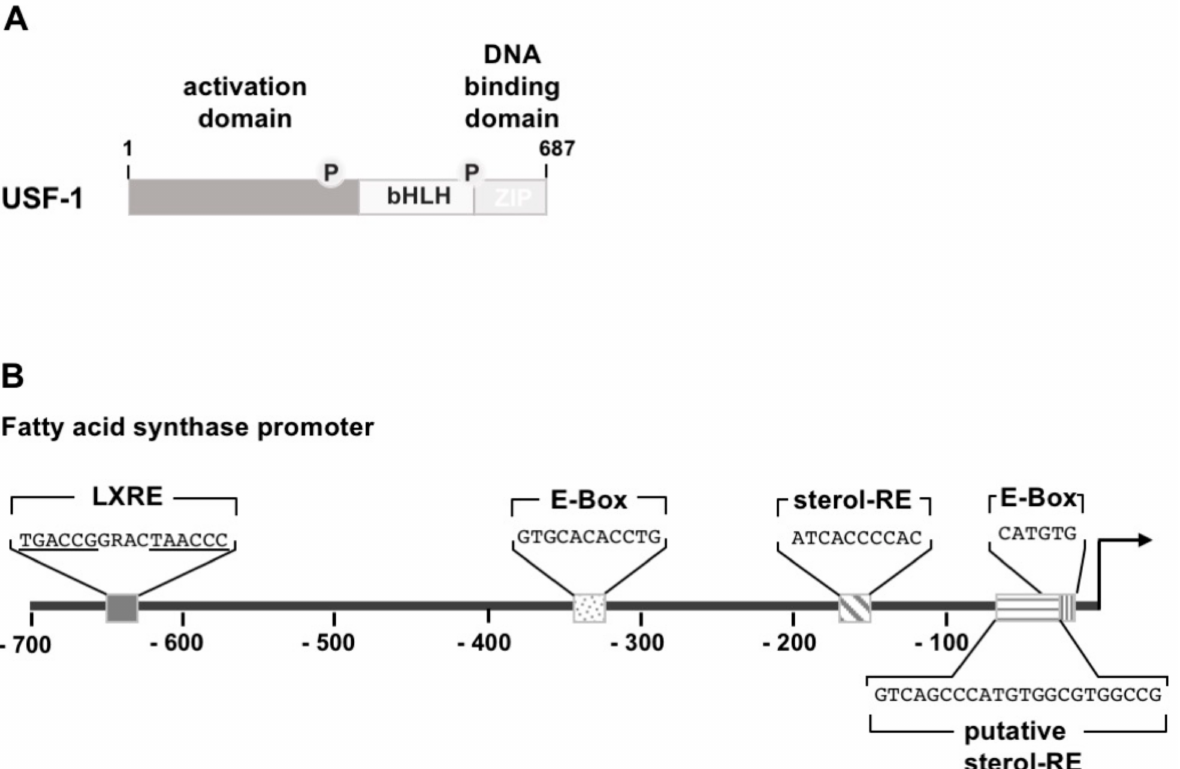
Figure 3. Modular structure and binding sites of upstream stimulatory factor (USF). ( A ) The USF protein USF-1 and USF-2 have a similar domain structure, encompassing an N-terminal activation domain, a basic helix-loop-helix domain (bHLH), and a C-terminal leucine zipper (LZ). ( B ) Transcription factor binding sites within the proximal fatty acid synthase promoter. Two USF binding sites (E-Box) are depicted. In addition, there is a binding site for SREBP-1c (sterol-responsive element). A second tandem binding site for SREBP-1c, overlapping with the proximal E-box, has been suggested. A binding site for liver X receptor (LXRE) is found in the proximal fatty acid synthase promoter. Additionally, there is an upstream binding site for carbohydrate response element-binding protein (ChREBP) at position -7382 to -6970, which is not depicted in the cartoon. The fatty acid synthase promoter sequence was obtained from GeneBank